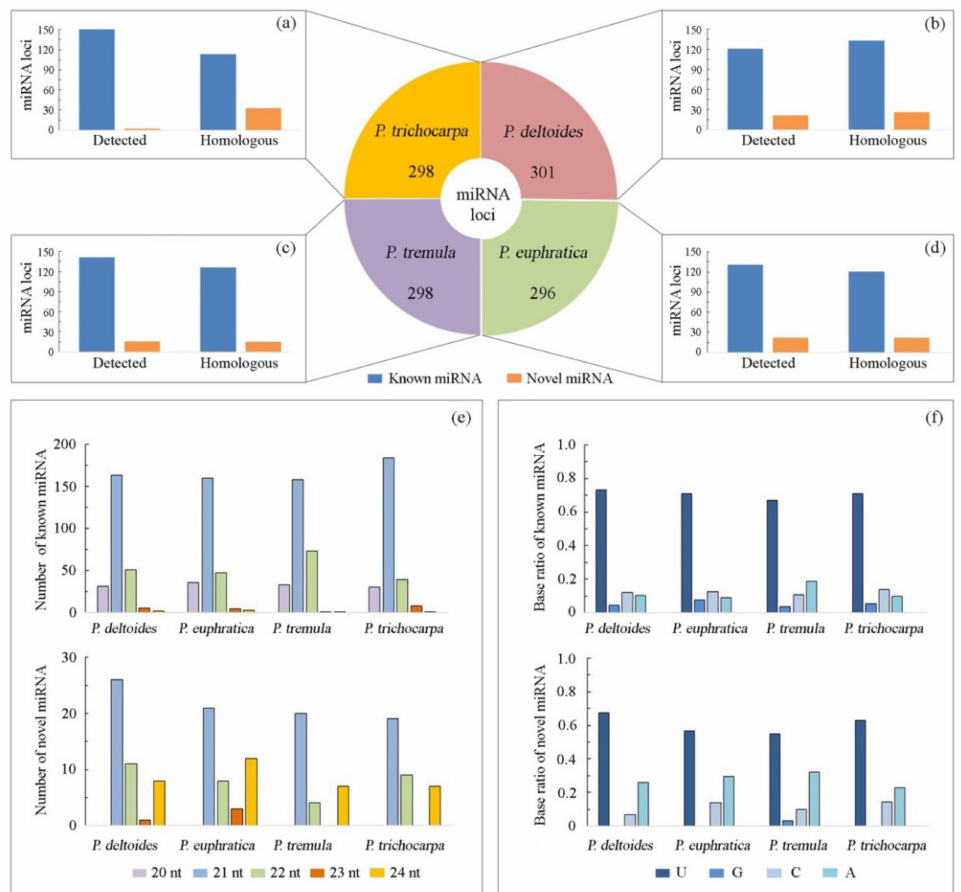
Figure 2. miRNA annotation of the four-poplar species by combining de novo and homolog-based genome-wide identification. The number of miRNA loci in P. deltoides , P. euphratica , P. tremula , and P. trichocarpa , respectively ( a – d ). The length of miRNAs ( e ) and distribution of bases at the 5 (cid:48) end of miRNAs ( f ) in the four